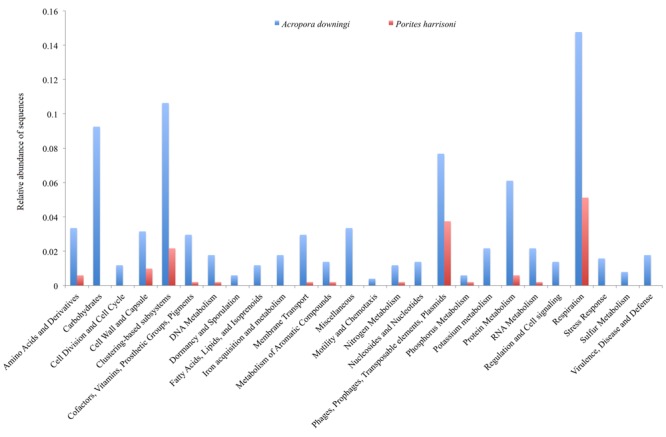
Relative functional gene sequences abundance in Arabian Gulf A. downingi and P. harrisoni viromes. Protein-encoding sequences were analyzed using BLASTX (E-value cut-off-10-5) to the MG-RAST subsystem database and grouped according to the highest hierarchal metabolic function or ‘subsystem.’